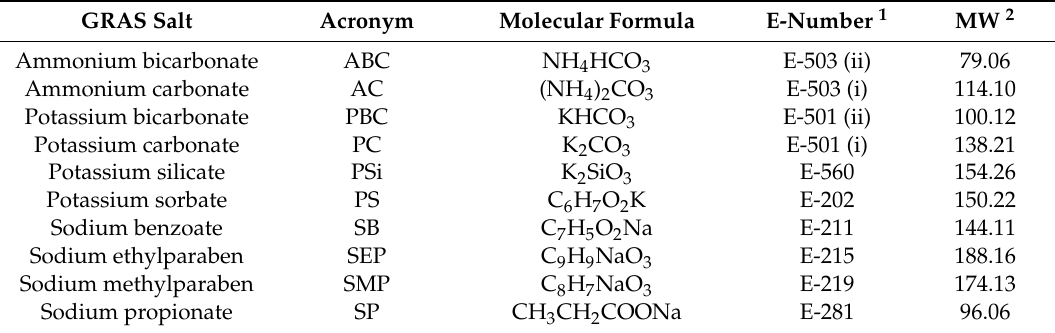
Table 1. Characteristics of antifungal GRAS salts tested in vitro to inhibit Colletotrichum gloeosporioides and in vivo as ingredients of edible coatings to control citrus